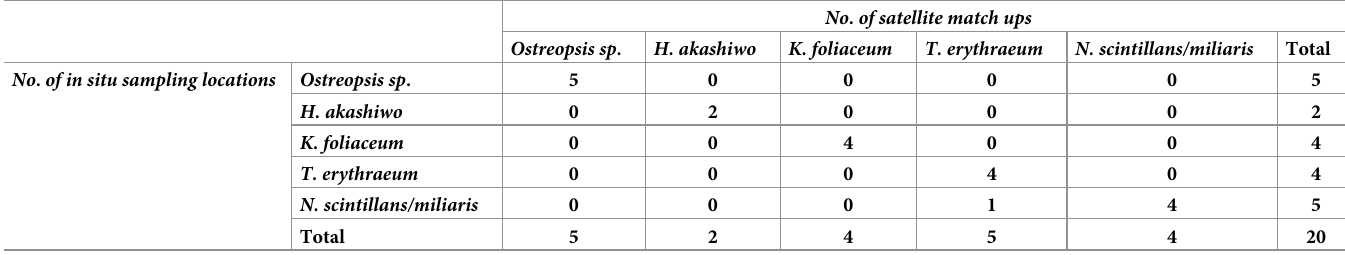
Table 4. Statistical accuracy assessment results for detecting the presence and absence of different HAB species in the Red Sea waters a .